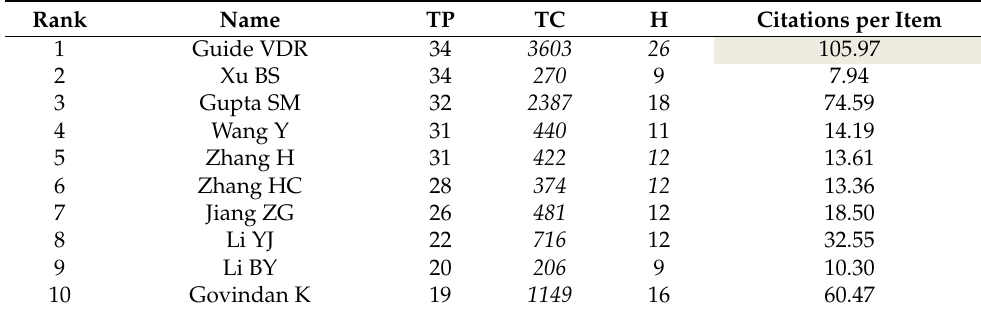
Table 6. Most productive and influential authors in remanufacturing